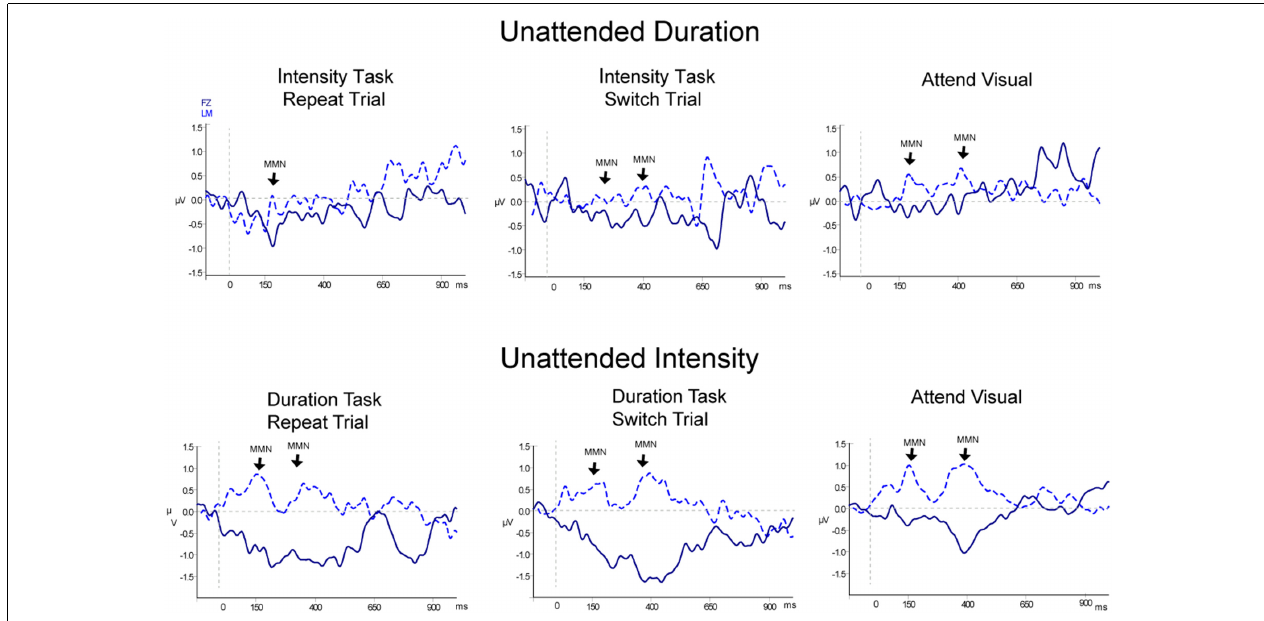
FIGURE 4 | Event-related potentials for non-target (unattended) pattern deviants. Difference waveforms (deviant-minus-standard) are displayed for duration (top row) and intensity (bottom row) non-targets. Responses to the non-targets during the Attend Auditory conditions: Repeat trials are shown in the left column and Switch trials are shown in the middle column, and responses to the non-targets in the Attend-Visual condition are displayed in the right column. The dark blue solid line displays the waveform recorded from the Fz electrode with the waveform at LM (light blue dashed line) overlain. Significant MMN components are denoted with an arrow pointed at LM and labeled. Two successive MMNs were elicited by two successive tones within the non-target pattern deviants, similarly as for the targets shown in Figure 3 .